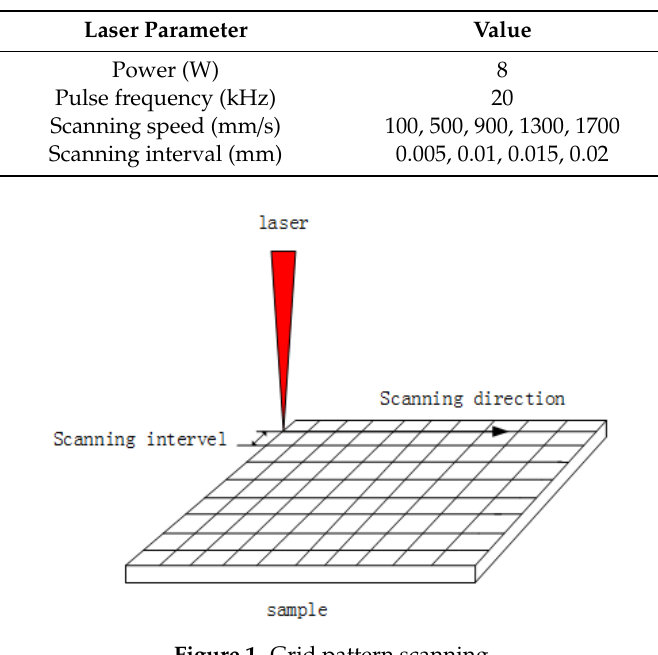
Figure 1. Grid pattern scanning.